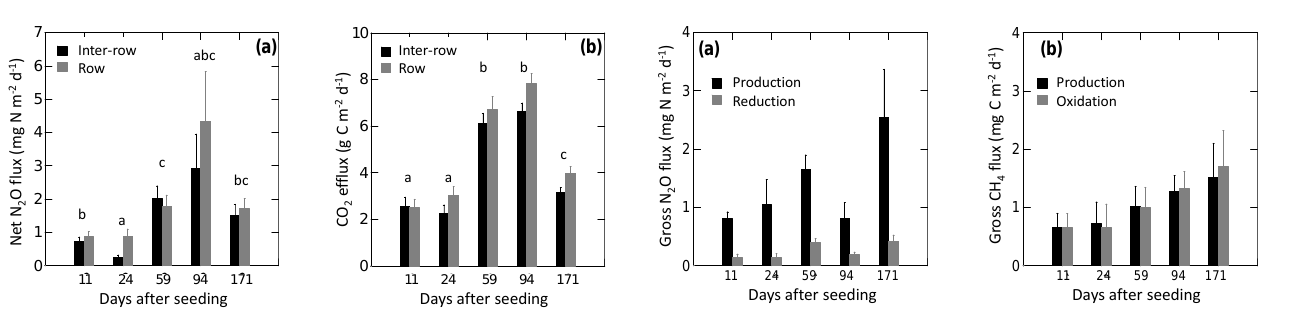
Figure 2. Mean (a) gross N 2 O production rates (black bars) and re- duction rates (grey bars) and (b) gross CH 4 production rates (black bars) and oxidation rates (grey bars). Error bars represent standard errors ( n = 8 per sampling